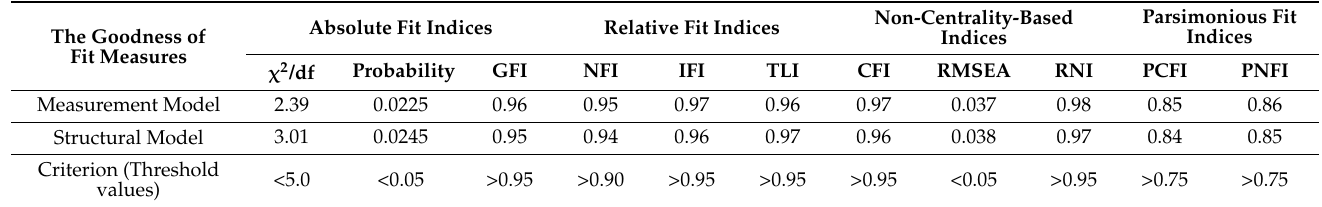
Table 6. Fit-indices